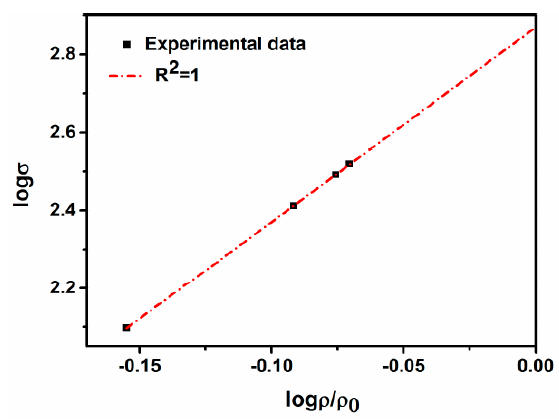
Figure 13. Change of the tensile strength (σ) with relative density (ρ/ρ 0 ) for the sintered alloys with different isothermal holding times.